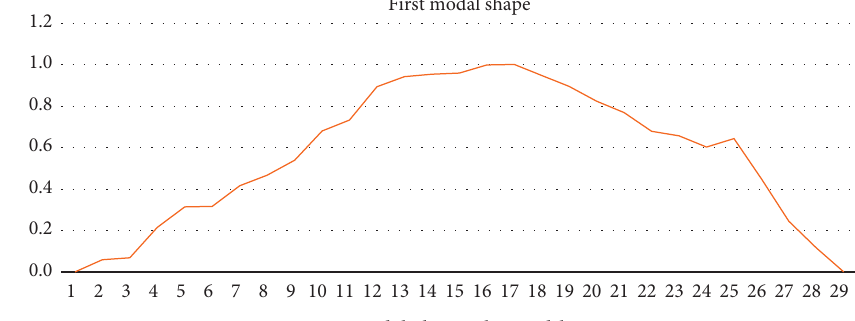
Figure 11: Modal shape obtained by OMA.